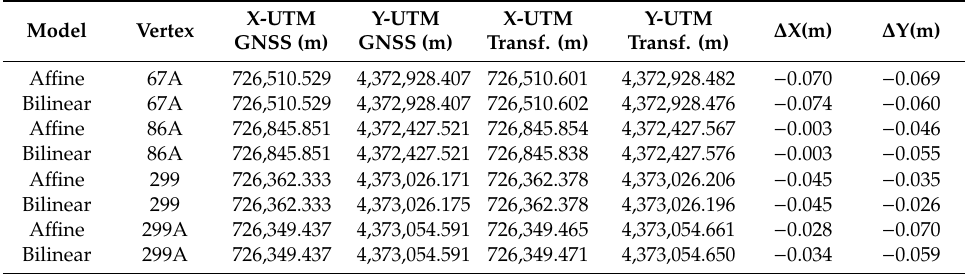
Table 8. Di ff erences between UTM-GNSS coordinate and UTM-transformed Table 8. Differences between UTM-GNSS coordinate and UTM-transformed coordinates.